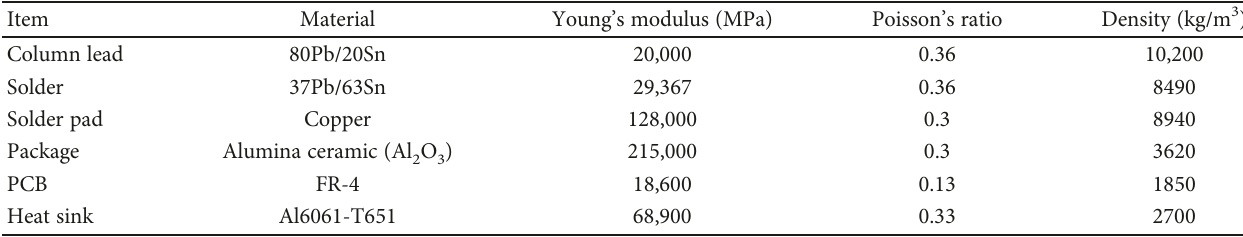
Figure 11: Con fi gurations of FEM ((a) Overall view, (b) Close-up view of the thermal gap pad). Table 5: Material properties for structural